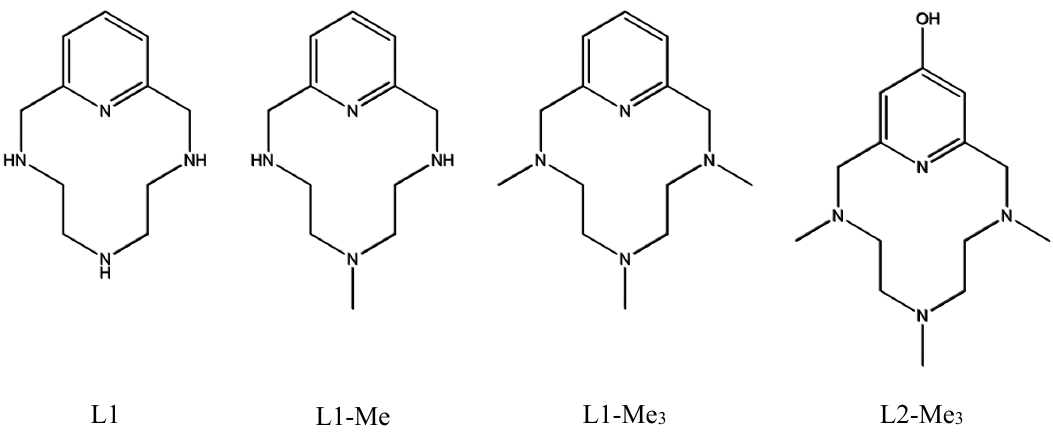
Figure 3. Structural formulas of the ligands employed in the current study.